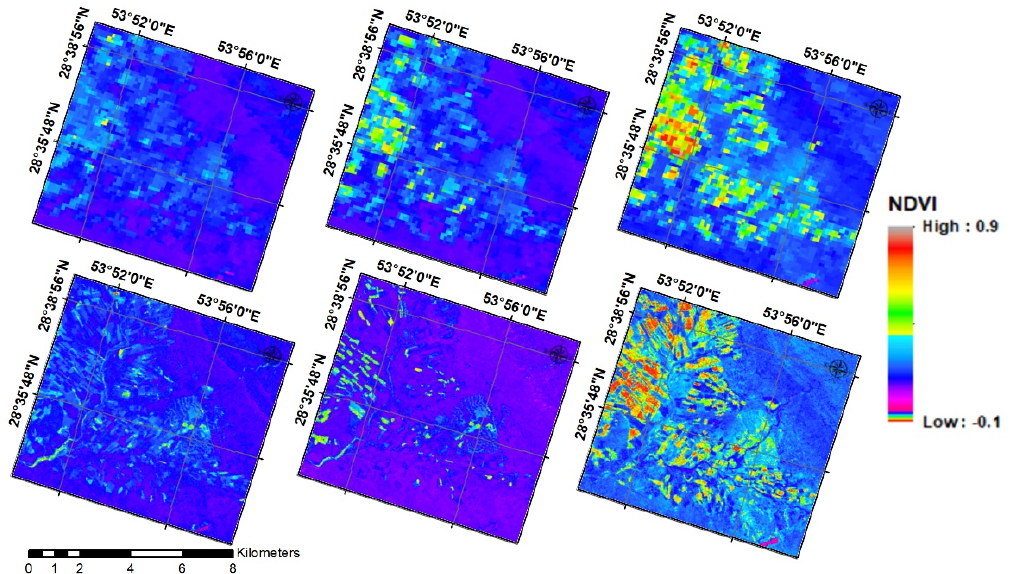
Figure 4. NDVI plots from MODIS (Moderate Resolution Imaging Spectroradiometer) ( Upper row ) and Landsat ( Lower row ) through the growing season.